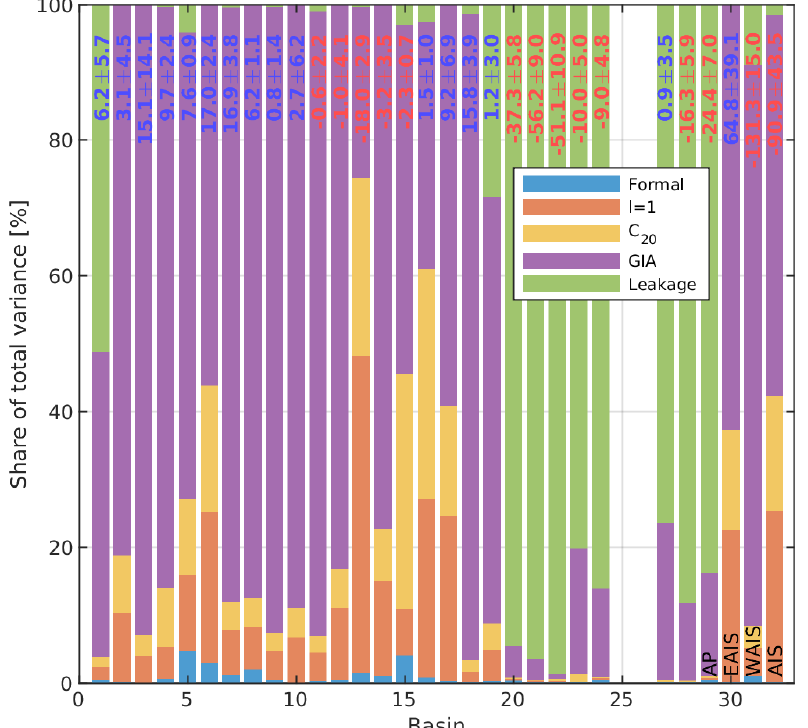
Figure 6. Components (bars) contributing to the overall uncertainty of the mass balance (numbers) for the final mass change basin products of variant (ICE,FAR,ANTOC,1.0). The overall uncertainty accounts for formal errors from the least-squares adjustment, for uncertainties of the degree l = 1 addition, related to the C 20 replacement, of the glacial isostatic adjustment (GIA) model correction and for leakage errors. Bars indicate the components’ share of the total